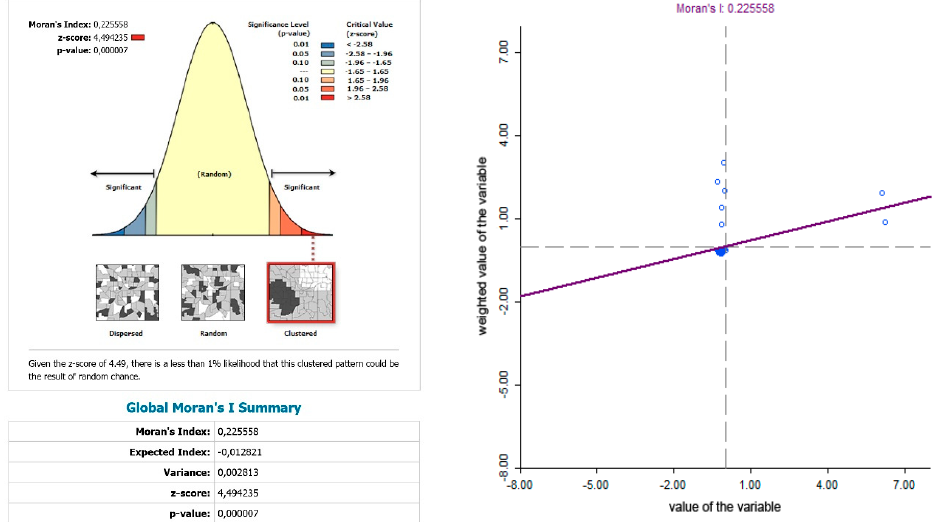
Figure 14. Standardized death rate of prostate cancer per 1000 inhabitants in European Standard Population, 2007–2012. Source: Statistical Office of the Slovak Republic, 2019.